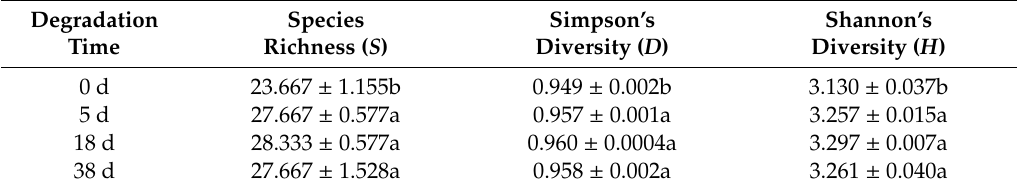
Table 4. Species richness ( S ), Simpson’s diversity ( D ) and Shannon’s diversity ( H ) indexes of phytoplankton-associated bacterial